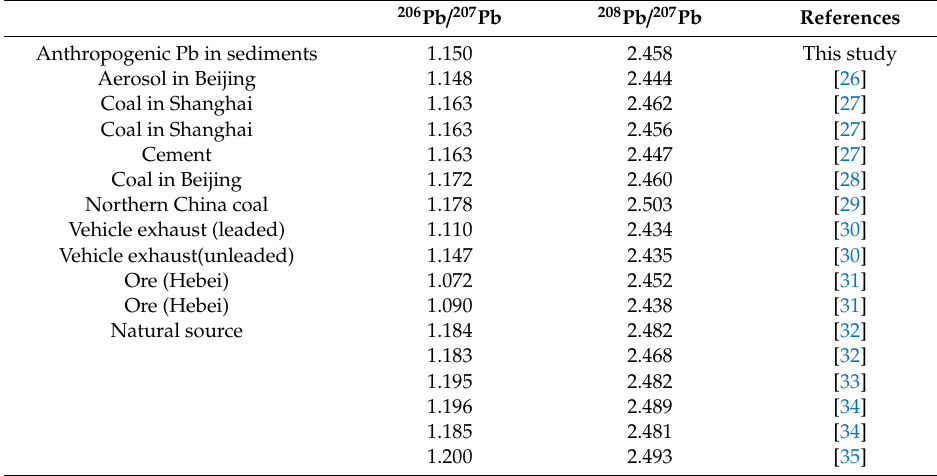
Table 1. Values of Pb isotope ratio of different sources. 206 Pb / 207 Pb 208 Pb / 207